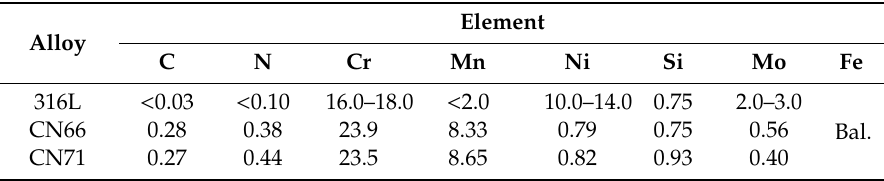
Table 1. Chemical compositions of stainless steel 316L, CN66 and CN71, Fe-Cr-Mn-C-N high interstitial stainless cast steels (unit: mass